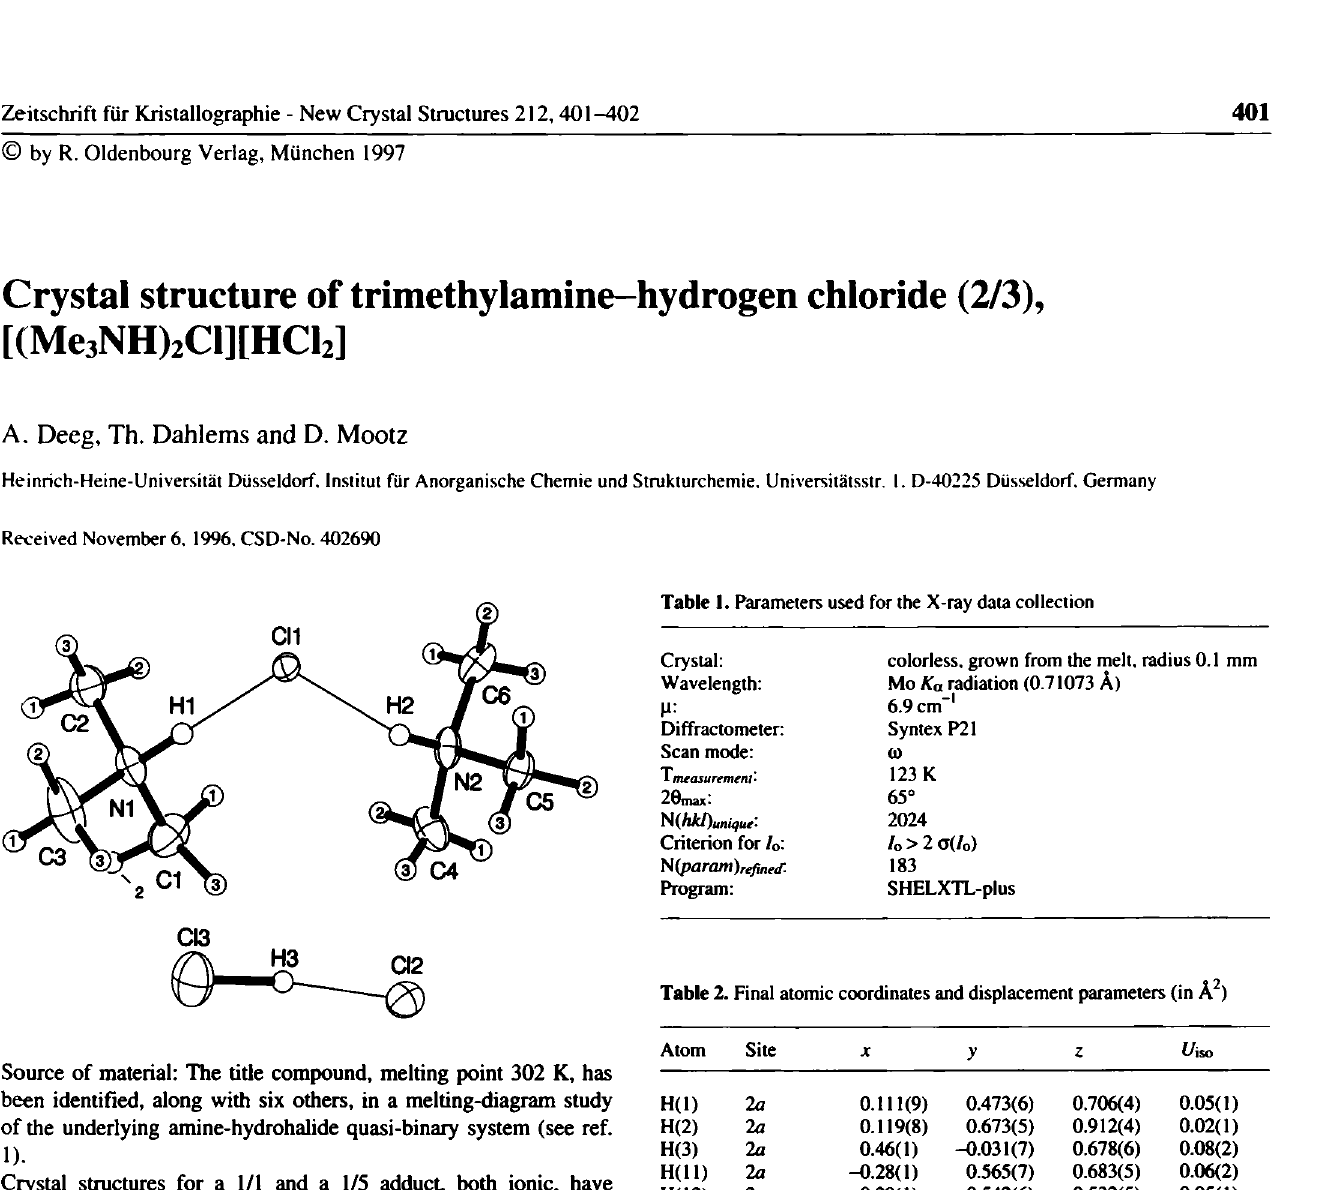
Table 2. Final atomic coordinates and displacement parameters (in À 2 )